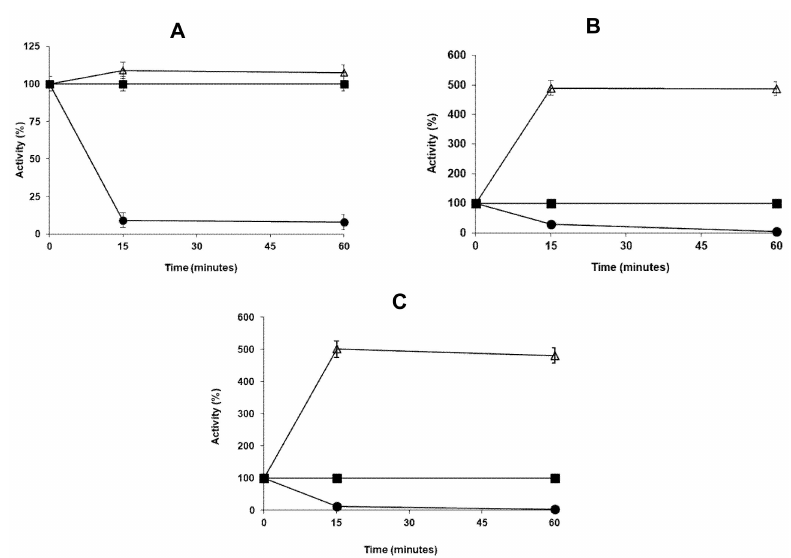
Figure 1. Immobilization course Pseudomonas fluorescens (PFL) ( A ), Rhizomucor miehei (RML) ( B ), and Lecitase Ultra (LU) ( C ) in octyl agarose beads. The experiments were performed using an enzyme loading of 1 mg / g of support as described in Methods. Solid squares: reference, solid circles: supernatant; and empty triangles: suspension.